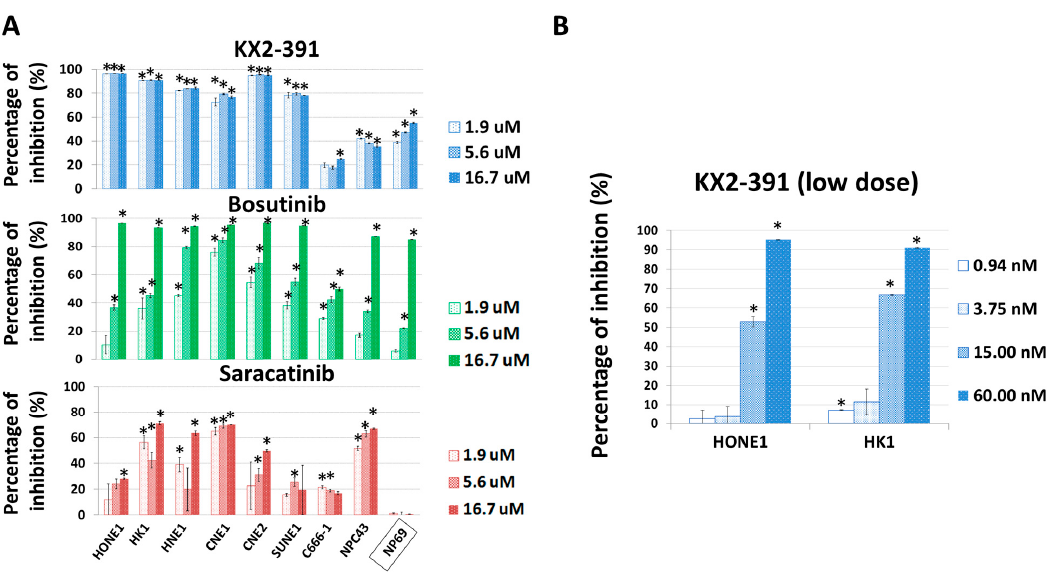
Figure 5. SRC inhibitors suppress the growth of NPC cells. ( A ) The in vitro growth inhibitory effects of KX2-391, bosutinib, and saracatinib were tested with a panel of NPC cell lines and the immortalized NP cell line NP69. The numbers of viable cells were detected by the MTT assay after treatments for 3 days. The relative inhibition rate was compared with the corresponding vehicle control. ( B ) The effects of low dosages of the SRC inhibitor KX2-391 on the in vitro growth of NPC cells. Four concentrations were used. The numbers of viable cells were detected by the MTT assay after treatments for 3 days. The relative inhibition rates were compared with their corresponding vehicle controls. *: p < 0.05.